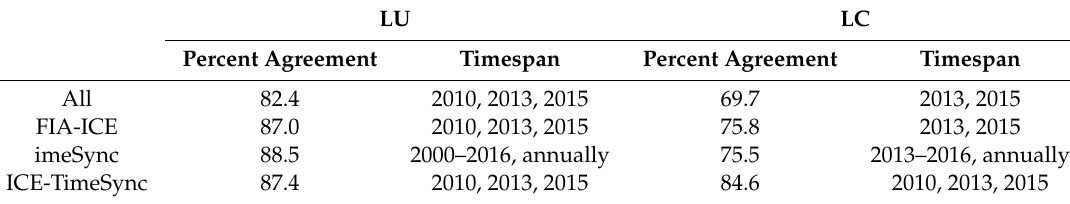
Table 1. Plot-level agreement between two and three sources of land use and land cover information collected on FIA plots. The lower overall agreement across the three data sets implies that the pairwise agreement occurs on di ff erent plots across the three pairings.